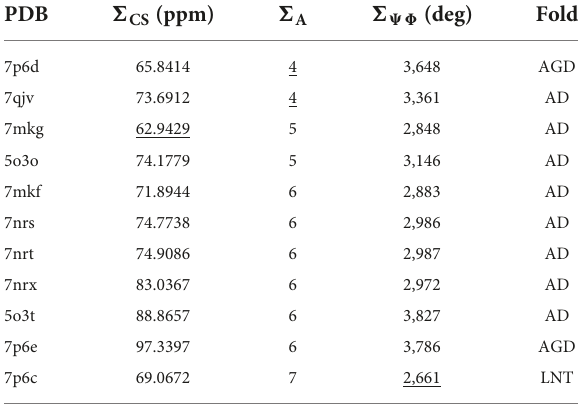
Subset of results from the three metrics introduced in the text, namely, (cid:54) CS (equation 1), (cid:54) A (equation 2), and (cid:54) (cid:57)(cid:56) (equation 3). Best (i.e., minimal) values for each metric are underlined. The table is sorted according to (cid:54) A and the eleven best results areshowntogetherwiththecorrespondingPDBidentificationcodesandthetypeoffold (AGD, argyrophilic grain disease; AD, Alzheimer’s disease; LNT, limbic-predominant